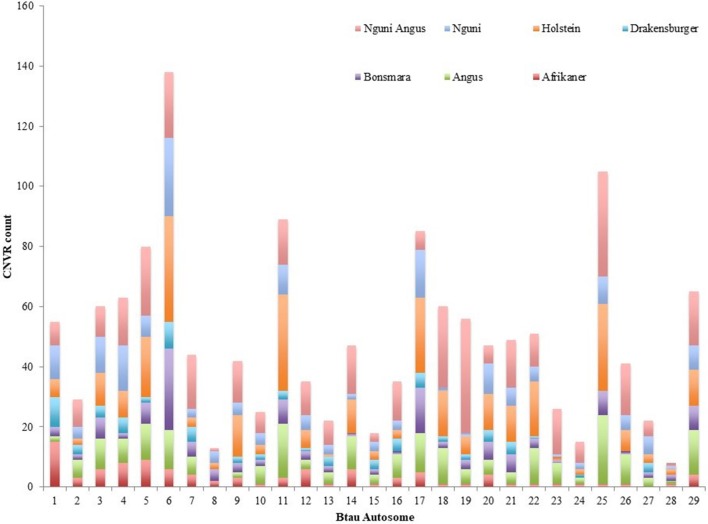
Chromosomal distribution of CNVRs for each of seven cattle breeds.